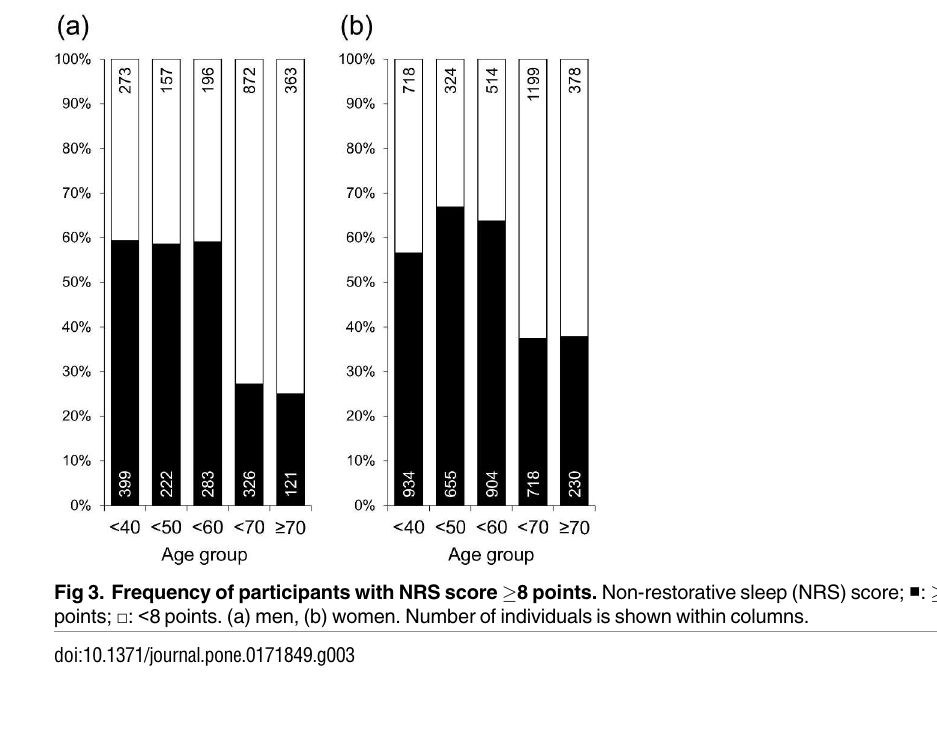
Table 5. Differencesin clinical parameters according to the NRS